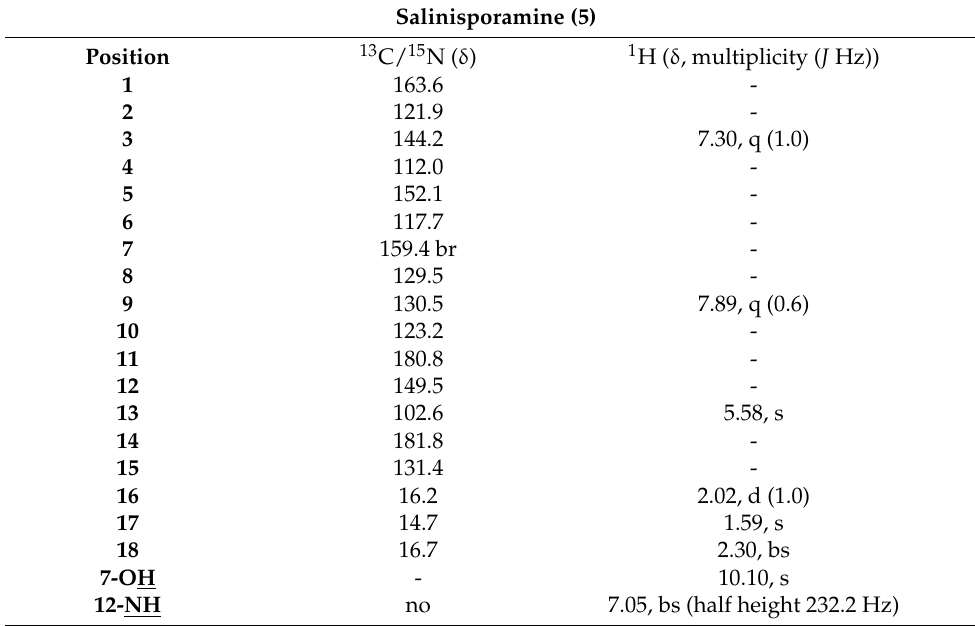
Table 2. NMR data for salinisporamine ( 5 ) recorded in DMSO- d 6 at 600